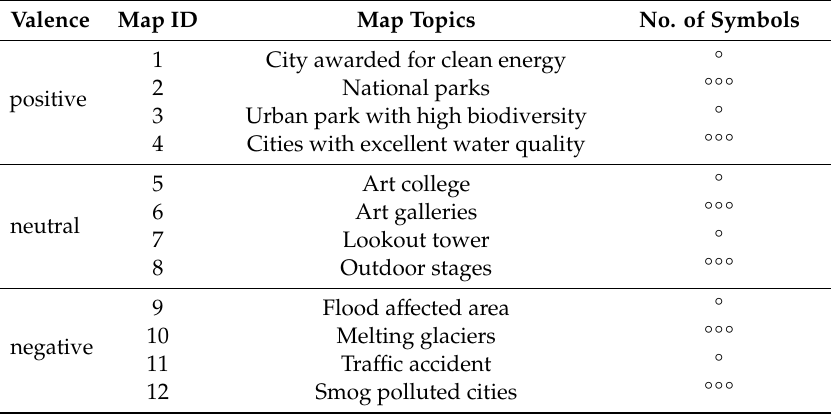
Note: ◦ indicates one map symbol, ◦◦◦ indicates three map